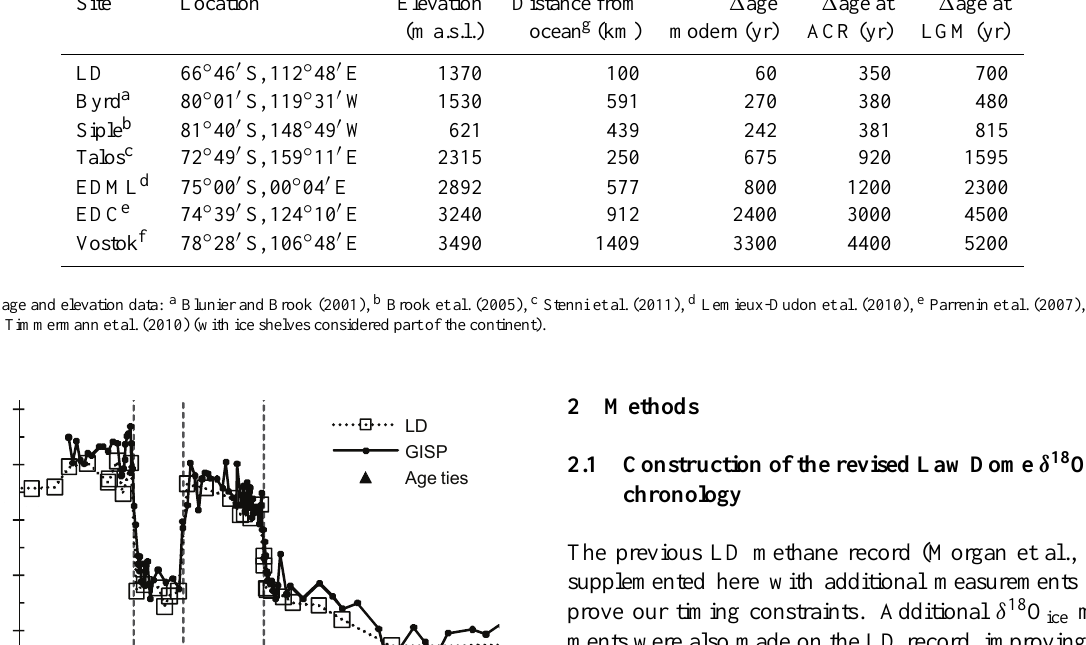
Table 1. Site characteristics and 1 age values during modern, ACR, and LGM times at the Antarctic ice core sites mentioned in the text. Site Location